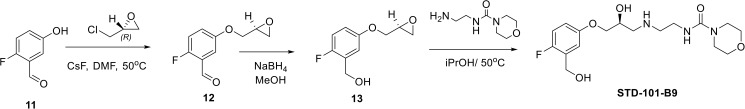
Synthesis of STD-101-B9.